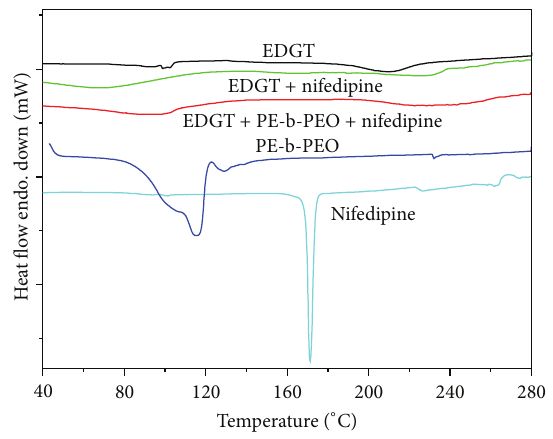
Figure 8: Comparison of DSC thermograms of Eudragit, PE-b- PEO, EDGT + nifedipine, EDGT + PE-b-PEO + nifedipine, and pristine nifedipine.